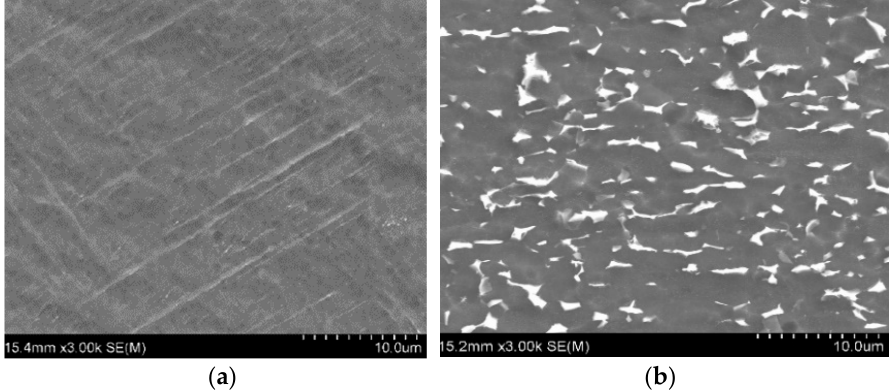
Figure 1. SEM micrographs of ( a ) SLM sample showing α ’ martensitic structure, ( b ) CP sample showing fine and irregular β particles in α -matrix.